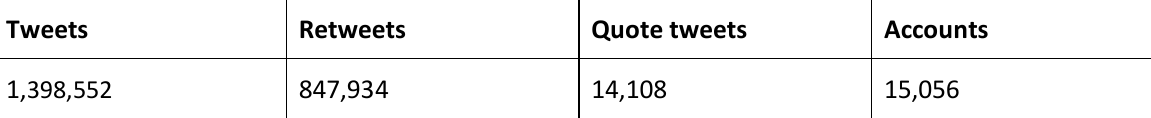
Table 3. Dataset